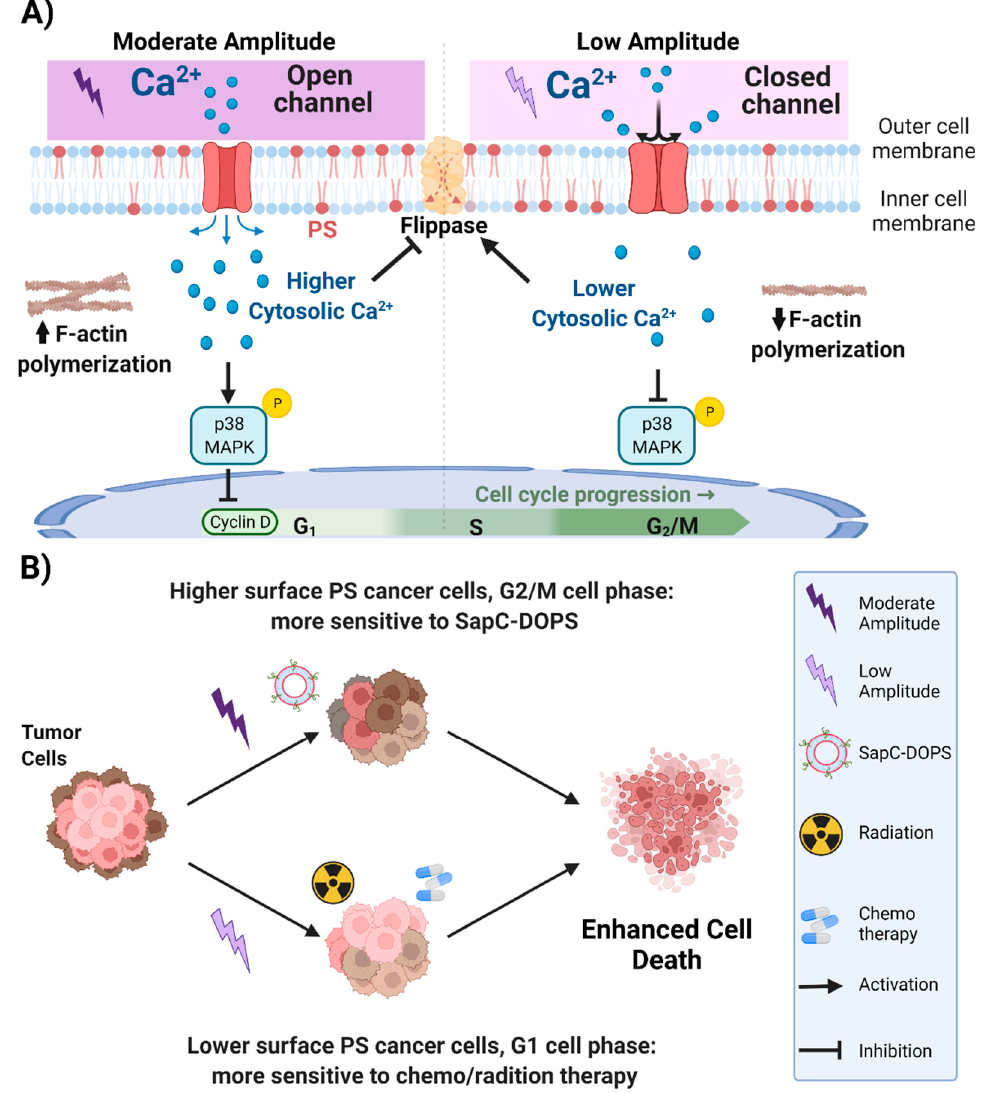
Figure 7. ( A ) Possible mechanism of action of the electric field in cancer cells. Moderate amplitude EF activates the voltage-gated calcium channels on the cancer cell membrane, leading to cytosolic calcium increase within the cells. Increased cytosolic calcium inhibits flippase activity and further accumulates PS on the outer cell membrane. Next, higher cytosolic calcium induces actin polymerization and activates the p38 MAPK pathway in cancer cells; this activation blocks the expression of cyclin D. On the other hand, low amplitude EF inhibits the activation of calcium channels, which leads to a lower cytosolic calcium concentration within the cells. Decreased levels of cytosolic calcium results in the activation of the flippase enzymes, which leads to reduced PS localization on the outer cell membrane. Moreover, this process inhibits further activation of p38 MAPK and actin polymerization. ( B ) Potential therapeutic application of low amplitude electric field. Moderate amplitude EF increases the PS exposure of cancer cells, whereas low amplitude EF decreases their PS exposure. The cancer cells treated with the moderate amplitude EF will end up with higher PS exposure and become more sensitive to high-PS targeting treatments such as SapC-DOPS. Conversely, cancer cells treated with low amplitude EF will have lower PS surface exposure and, therefore, become more sensitive to radiation and chemotherapy. Thus, the combination of moderate amplitude EF treatment with SapC-DOPS or low amplitude EF treatment with chemo/radiation may lead to enhanced cancer cell death, the main goal of anti-cancer